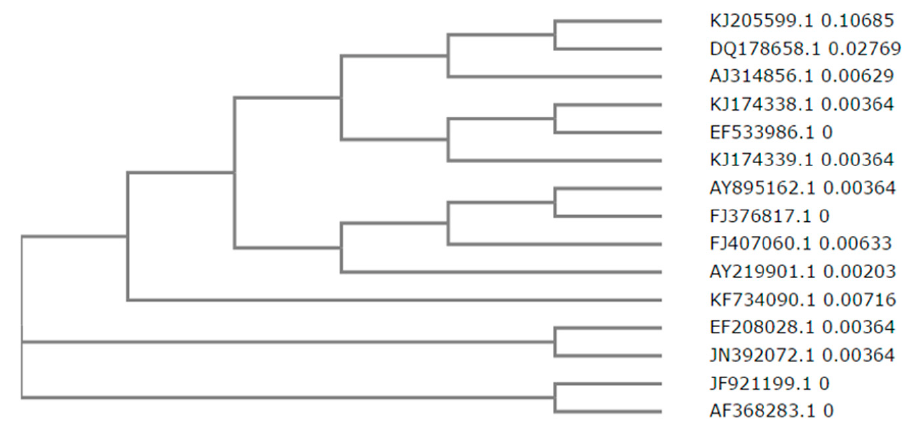
Figure 5. NK gene product and insoluble (inclusion-body) NK protein in Escherichia coli . ( A ) PCR- derived NK gene product from B. subtilis (natto); ( B ) Lane 1: NK protein present in crude medium extract; Lane 2 and 3: NK protein purified using a Ni-NTA (nickel-charged affinity nitrilotriacetic acid) column.